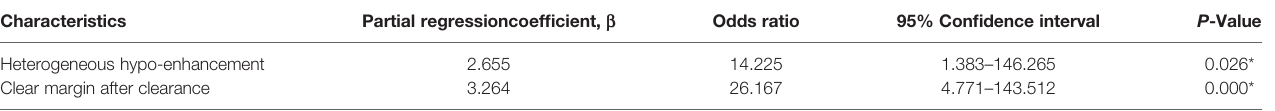
TABLE 3 | Multivariate logistic regression analysis of CEUS characteristics related to the B pattern MTNs distinguishing from PTCs.